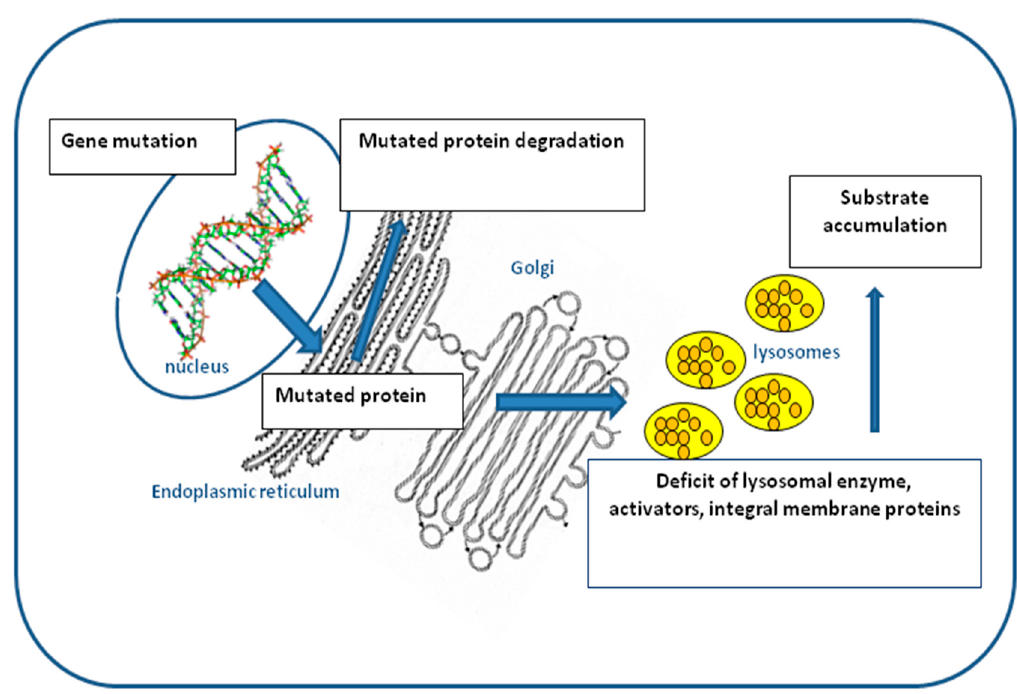
Figure 1. Schematic diagram of the events that lead to lysosomal storage disorders (LSDs). Orange spheres: accumulation of undegraded substrates.